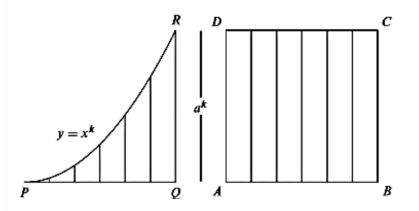
Figure 3. Comparing